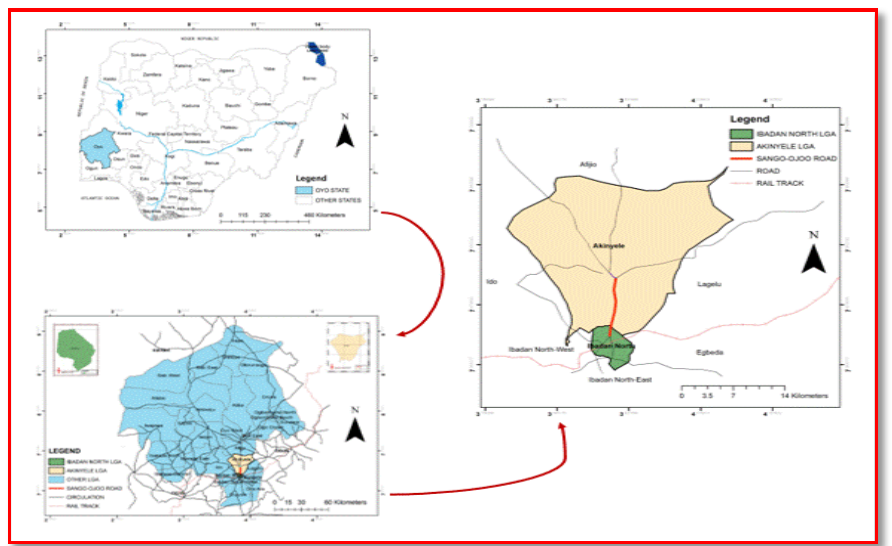
Figure 1. Map of study area